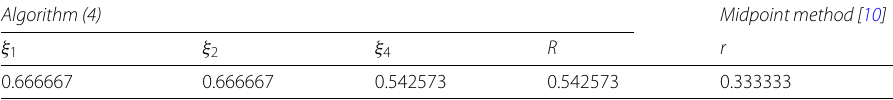
Table 2 Parameters for example 2 Algorithm(4)